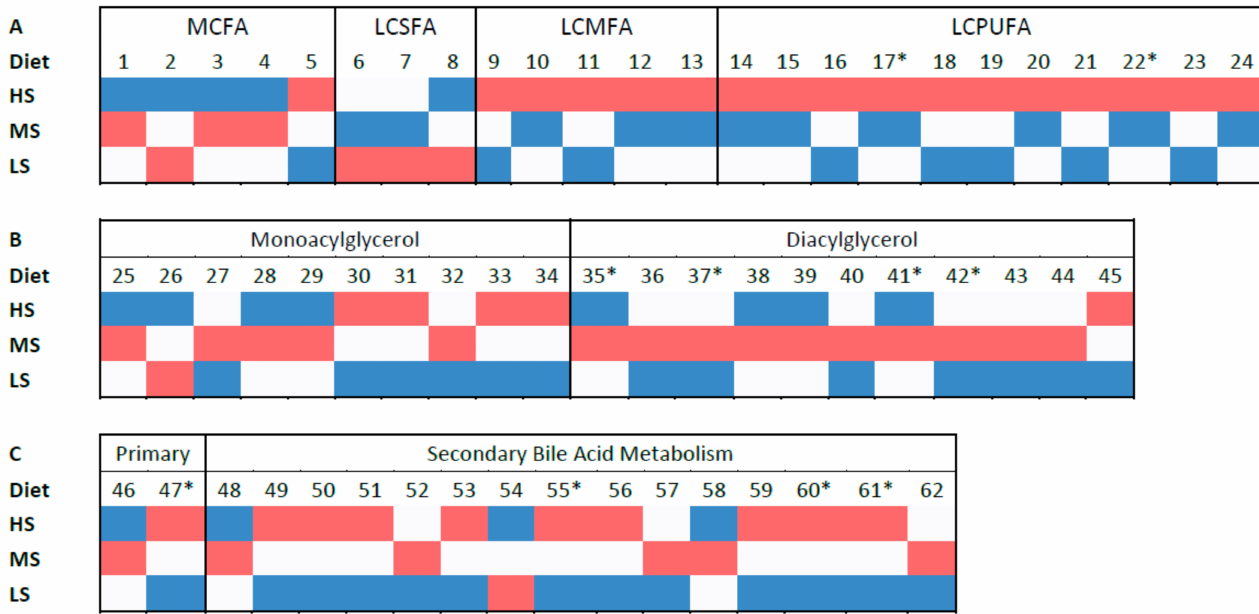
Figure 3. Fecal lipid metabolism analytes heatmap of dogs ( n = 24) fed diets produced at high, medium and low shear (HS, MS and LS, respectively), with each individual group of analytes (( A ): MCFA, medium-chain fatty acids; LCSFA, long-chain saturated fatty acids; LCMUFA, long-chain mono-unsaturated fatty acids; LCPUFA, long-chain poly-unsaturated fatty acids. ( B ): monoacylglycerols and diacylglycerols. ( C ): primary and secondary components of bile salt metabolism). Log 2 values were conditionally formatted within each metabolite across diets on a color scale. Blue indicates a relative concentration lower than the other treatments, white indicates an intermediate relative concentration, and red indicates a higher relative concentration than the other treatments. ( A ): 1, caproate (6:0); 2, heptanoate (7:0); 3, caprylate (8:0);